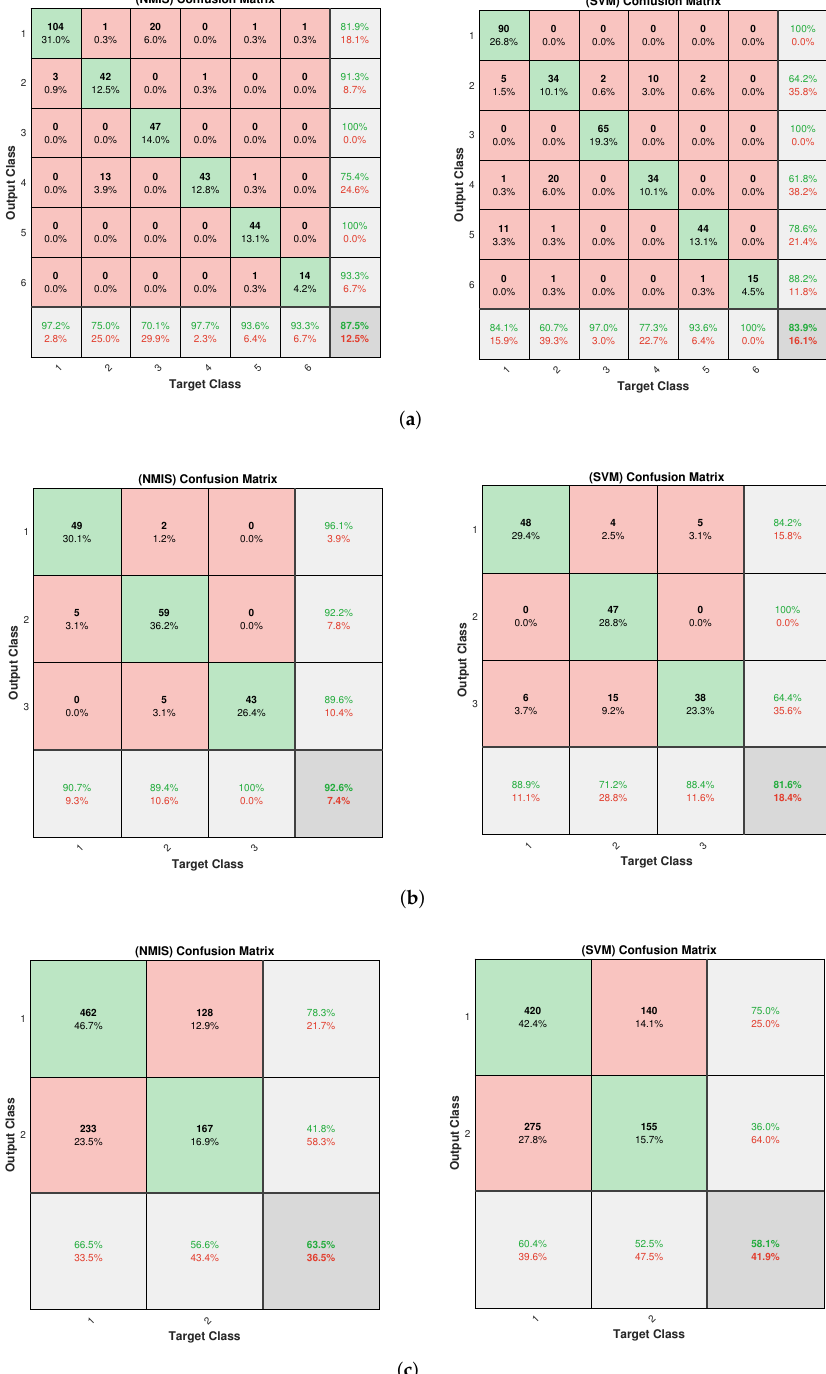
Figure 7. The confusion matrix of NMIS and SVM on ( a ) DERMATOLOGY, ( b ) WINE and ( c ) GERMAN datasets. Each orange square represents the number of wrongly predicted instances. The main diagonal represents the number of correctly predicted instances. The bottom and right light gray rectangles indicate the prediction accuracy of the corresponding instance